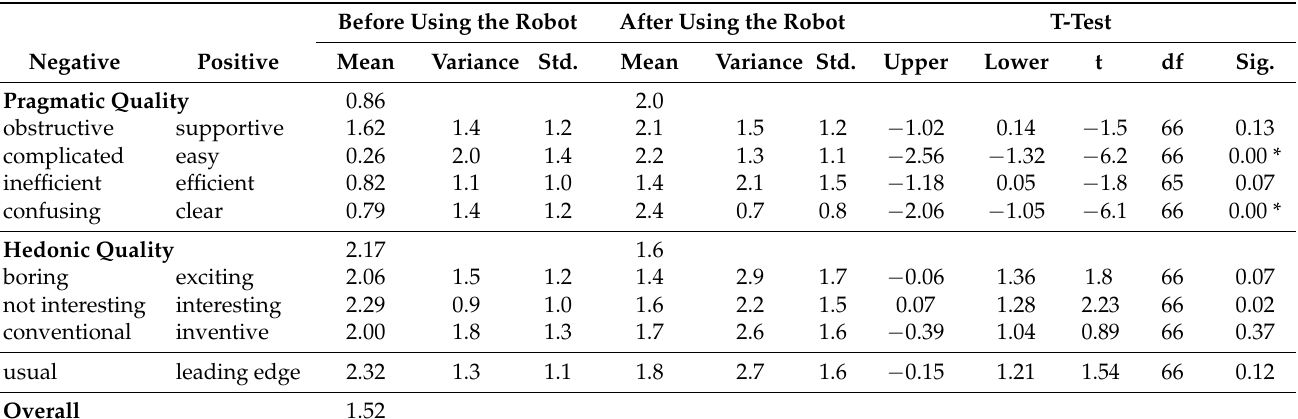
Table 5. Results for UEQ-S ( n = 34). * p values < 0.001.